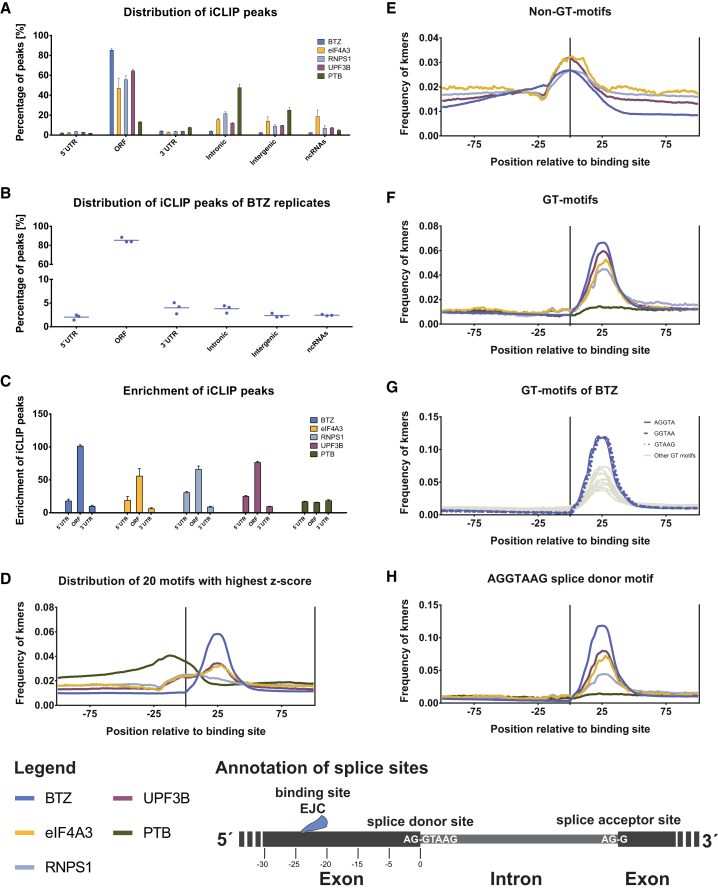
The Distribution of iCLIP Peaks Validates the Predominantly Sequence-Independent Deposition of EJC Proteins at Exonic Regions(A) Relative distribution of peaks for all iCLIP data sets confirms that EJC components bind predominantly in the ORF.(B) Distribution of BTZ peaks indicates the high reproducibility of the biological replicates; horizontal lines highlight the mean of three biologically independent BTZ iCLIP replicates.(C) Enrichment of iCLIP peaks at mRNA regions calculated by dividing the number of iCLIP peaks by the cumulative length of indicated regions reveals that the ORF harbors by far the most EJC binding sites, followed by the 5′ UTR, and then the 3′ UTR regions. The error bars represent SEM of n = 3 independent biological experiments.(D–H) The higher enrichment of the splice site signal compared to motifs within the reads confirmed the predominant sequence-independent deposition of the EJC. These graphs display the distribution of 5mer motifs around the binding site of the protein (illustrated as the vertical line in the middle of the plots).(D) Average distribution of the 20 most enriched motifs (see also Table S2) relative to the binding site.(E) Average distribution of 5mers that do not contain GT in their motif.(F) Average distribution of 5mers that do contain GT in their motif.(G) The distribution of GT-containing 5mers in BTZ iCLIP experiments revealed three prominent motifs (AGGTA, GGTAA, and GTAAG).(H) These most enriched GT-containing 5mers concatenate to the canonical splice donor site AGGTAAG, which is enriched in all EJC, but not in the PTB, libraries.See also Figure S2 and Tables S1–S3.